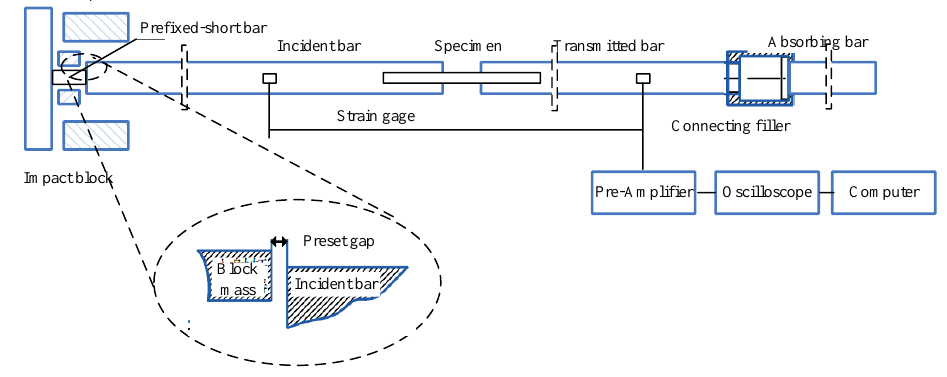
Figure 2. Split-hopkinson bar system for high strain-rate recovery tests.